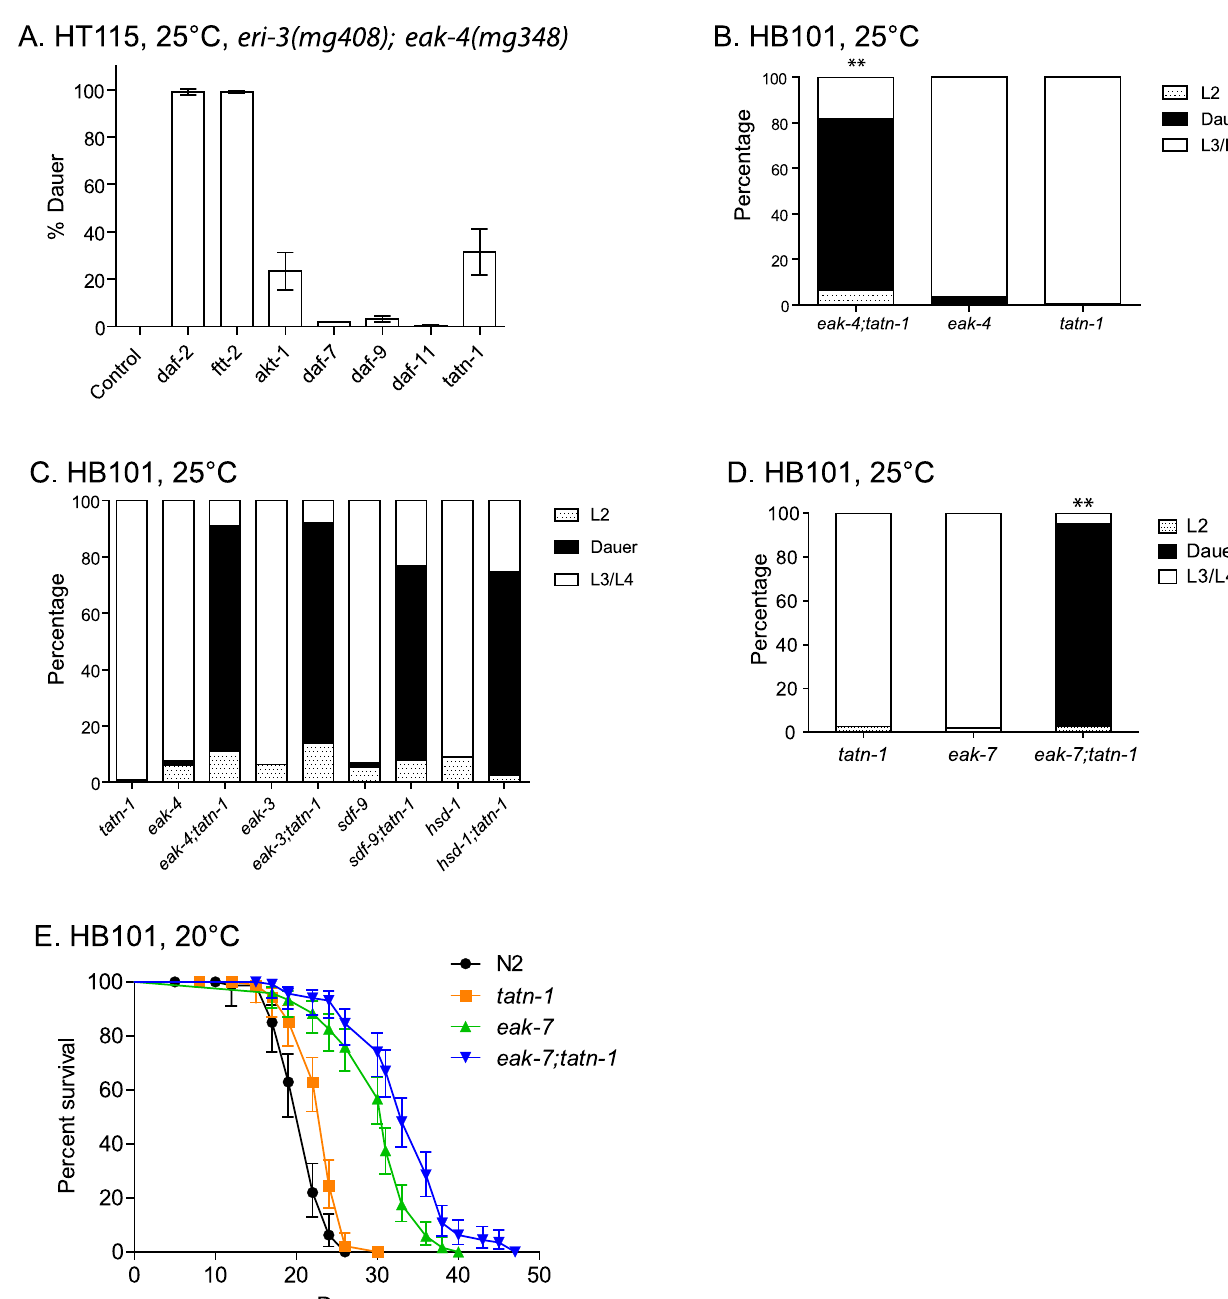
Figure 2. Tyrosine aminotransferase mutations enhance eak dauer and lifespan phenotypes. (A) Effect of treatment of eri-3(mg408); eak- 4(mg348) mutants with RNAi clones for daf-2 , ftt-2 , akt-1 , daf-7 , daf-9 , daf-11 , and tatn-1 on dauer arrest at 25 u C. Bars represent mean percentage of dauers observed in two trials, and the error bars represent standard deviation. The empty vector RNAi vector was used as a negative control. (B) Enhanced dauer formation by eak-4(mg348);tatn-1(baf1) versus the eak-4(mg348) or tatn-1(baf1) mutations alone. ** p , 0.001 for pairwise Fisher’s exact test. (C) tatn-1 mutations enhance dauer arrest by eak-3(mg344) , sdf-9(mg337) , and hsd-1(mg337) mutants. ** p , 0.001 for each double mutant compared to its respective eak single mutant by Fisher’s exact test. (D) tatn-1 enhances eak-7(tm3188) dauer arrest. ** p , 0.001 for comparisons between eak-7;tatn-1 and either tatn-1 or eak-7 alone. (E) tatn-1(baf1) extends the lifespan of both wild type and eak-7 worms. Shown are survival curves for wild type N2, tatn-1(baf1) , eak-7(3188) , and eak-7(3188); tatn-1(baf1) , with error bars showing the 95% confidence intervals for each point. The mean survival for N2, tatn-1 , eak-7 , and eak-7;tatn-1 are 21.0, 23.0, 30.0, and 33.5 days, respectively. p , 0.001 for all comparisons by log-rank test.